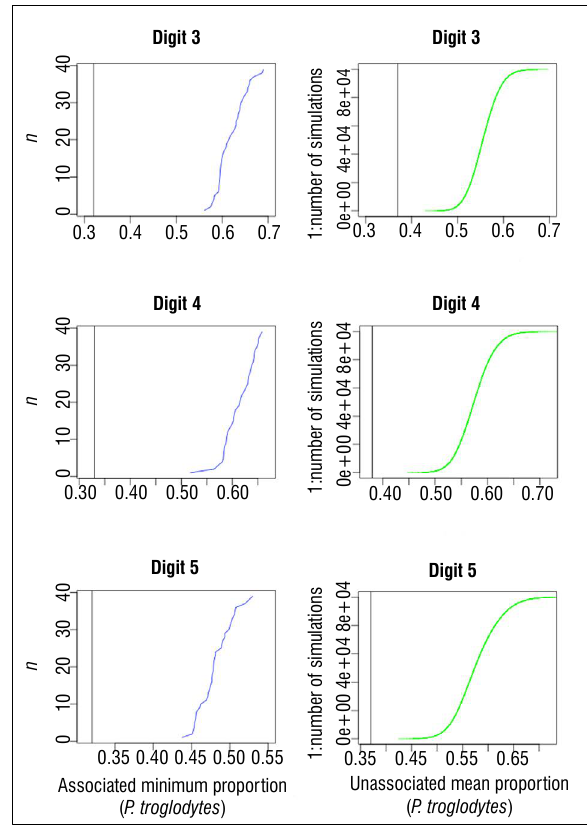
Figure 4: The associated (left) and unassociated (right) chimpanzee ( Pan troglodytes ) cumulative distribution functions (CDFs) for digits 3–5. Each corresponding Homo naledi value is represented by the vertical lines in each of the CDFs. The scales of the axes differ with digit and